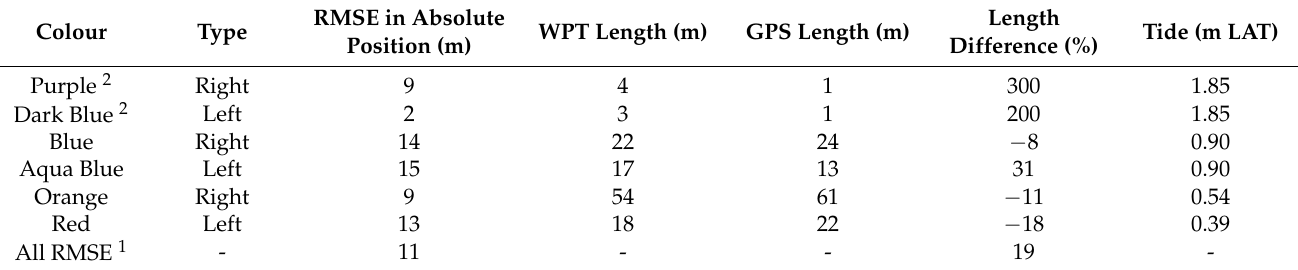
Table 2. GPS tracks compared with WPTs in the nearshore region.